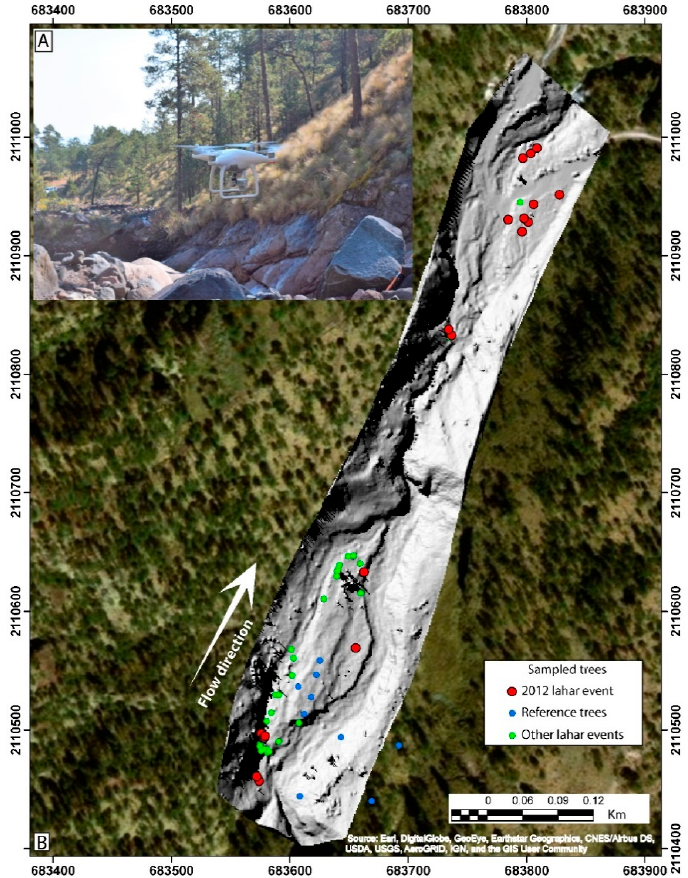
Figure 3. (A ) The digital terrain model shown was obtained from imagery taken with an unmanned aerial vehicle (UAV). ( B ) Digital terrain model (DTM) and location of trees sampled for dendrogeomorphic